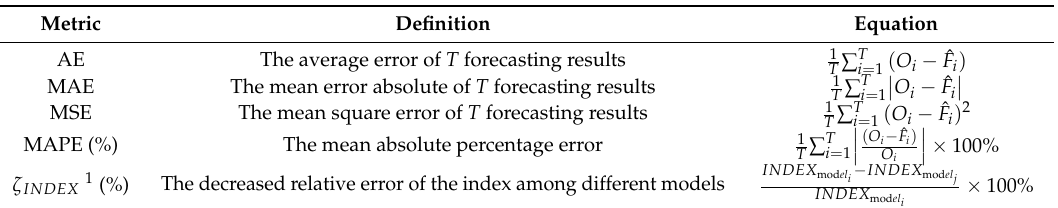
Table 1. Evaluation